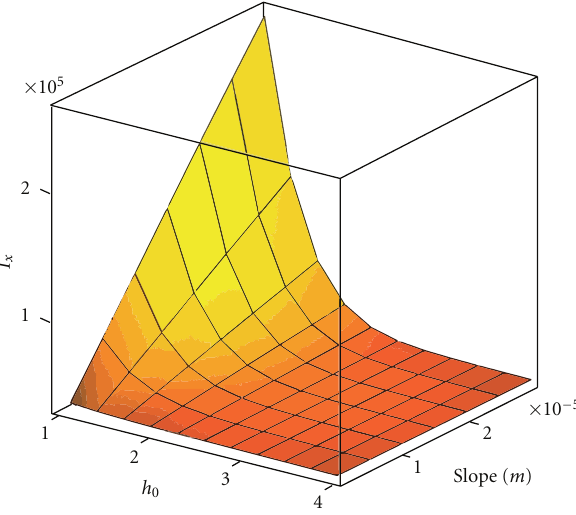
Figure 19: x N ( h 0 , β s ) for m = 2 × 10 − 5 and a =